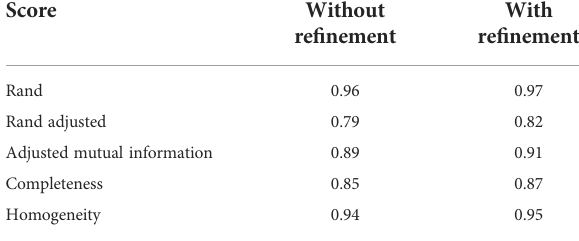
TABLE 4 Mean scores to evaluate instance segmentation results on the real Chenopodium data set, without and with the re fi nement stage explained in Section 2.4.